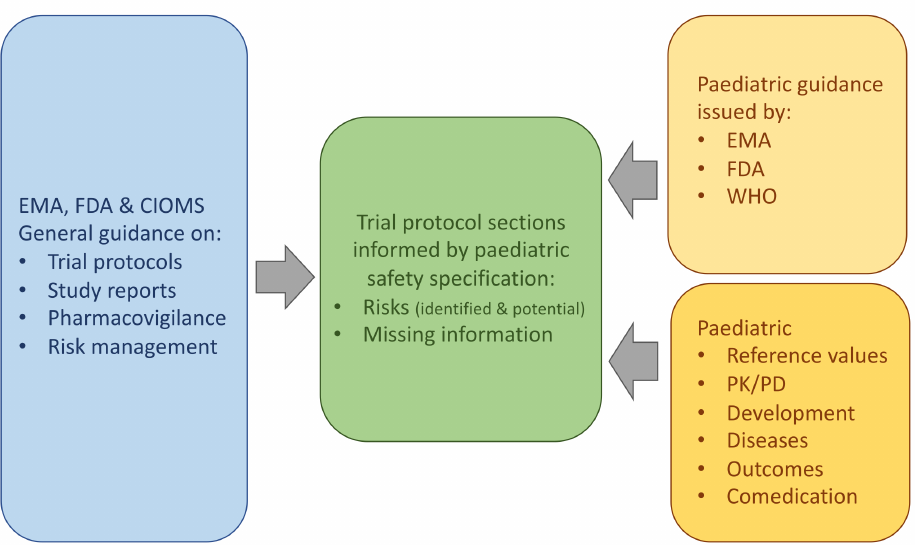
Figure 1. Paediatric research protocols and safety profiling. Process of combining informa- tion from health authorities, learned societies and the paediatric population. EMA—European Medicines Agency; FDA—Food and Drug Administration; CIOMS—Council for International Or- ganizations of Medical Sciences; WHO—World Health Organization; PK—Pharmacokinetic; PD—